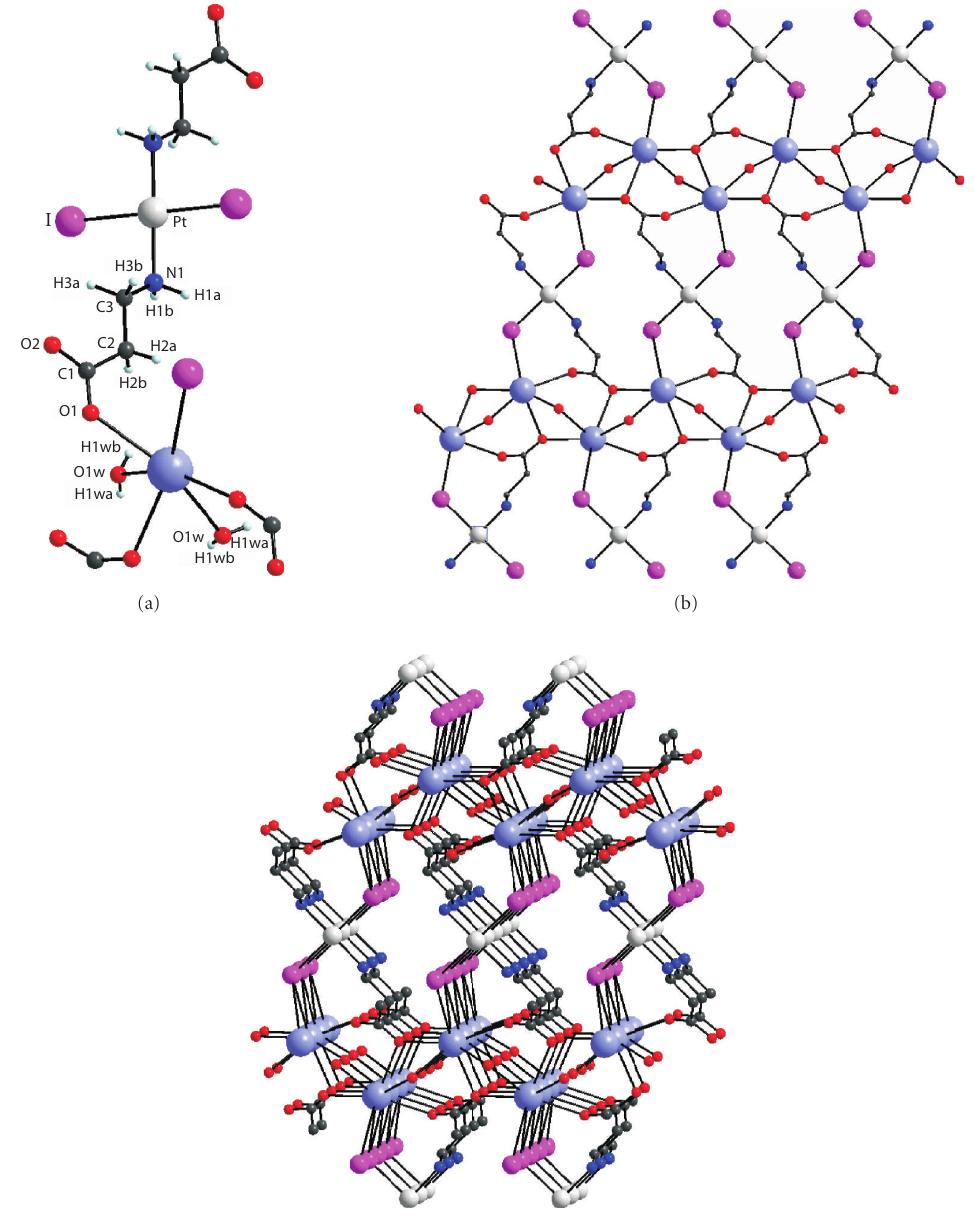
Figure 5: Atomic numbering scheme in an independent fragment (a); structure of the layer (b), and structure of the framework (c) in trans -K 2 [Pt( β -Ala) 2 I 2 ] • 2H 2